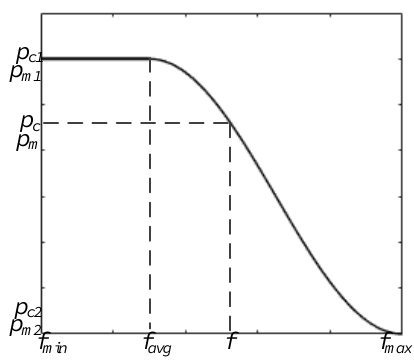
Figure 6. Cosine cross and mutation probability adjustment curve.